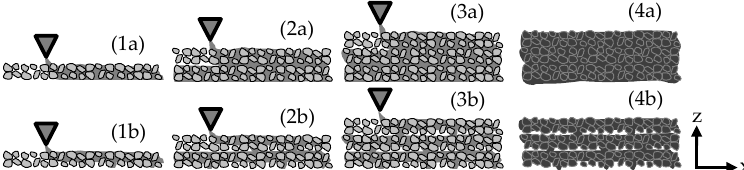
Figure 3. Production process with complete layer bonding/filling of voids (1a)–(4a) and with incomplete layer bonding/filling of voids (1b)–(4b) [28].